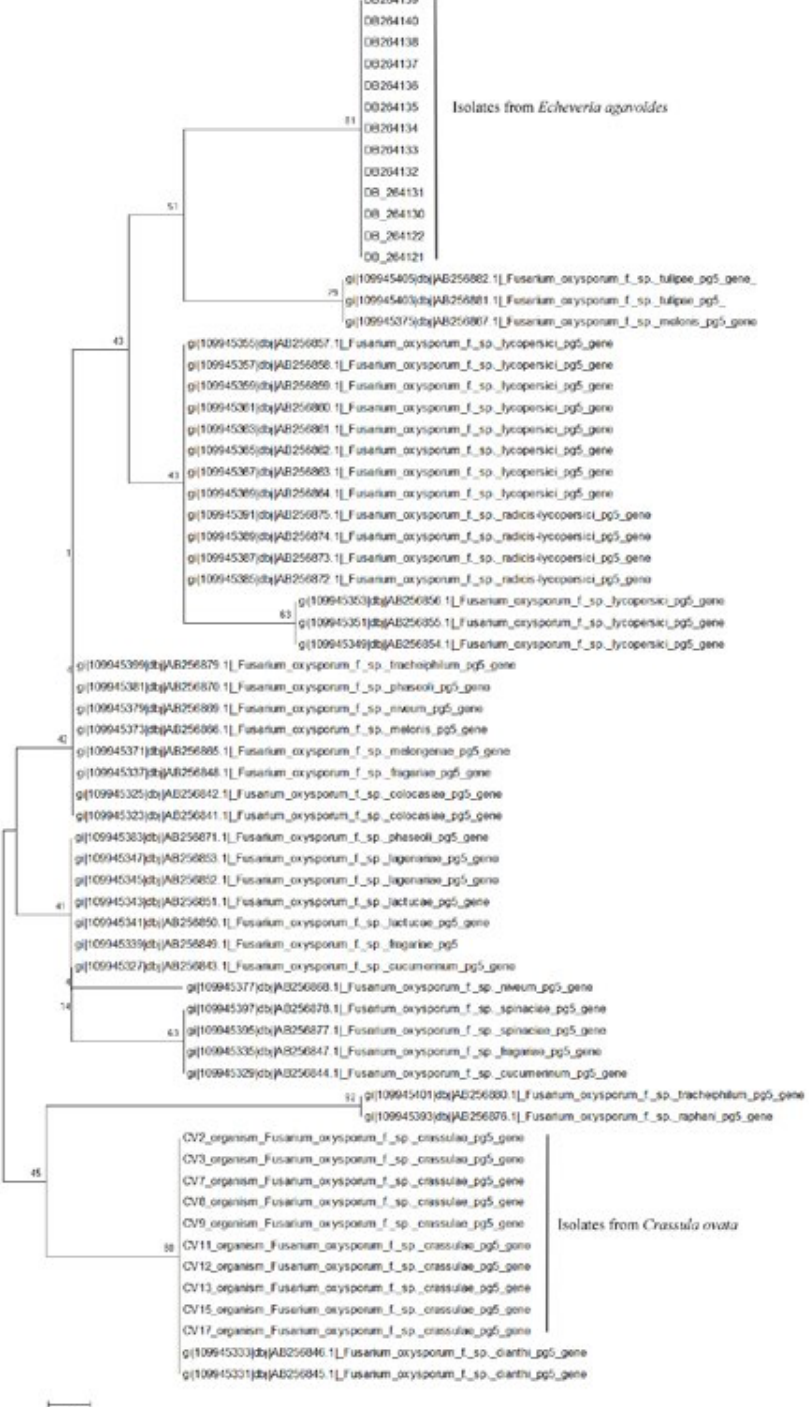
Figure 3. Phylogenetic tree based on Pg5 gene sequences, built by Mega5 software with the Neighbour joining method with 1,000 bootstrapping